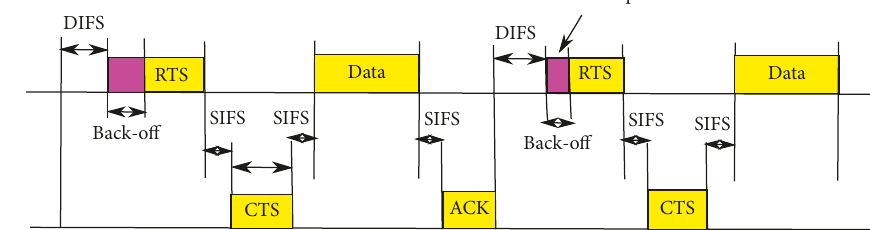
Figure 4: Back-off manipulation attack at the MAC layer.